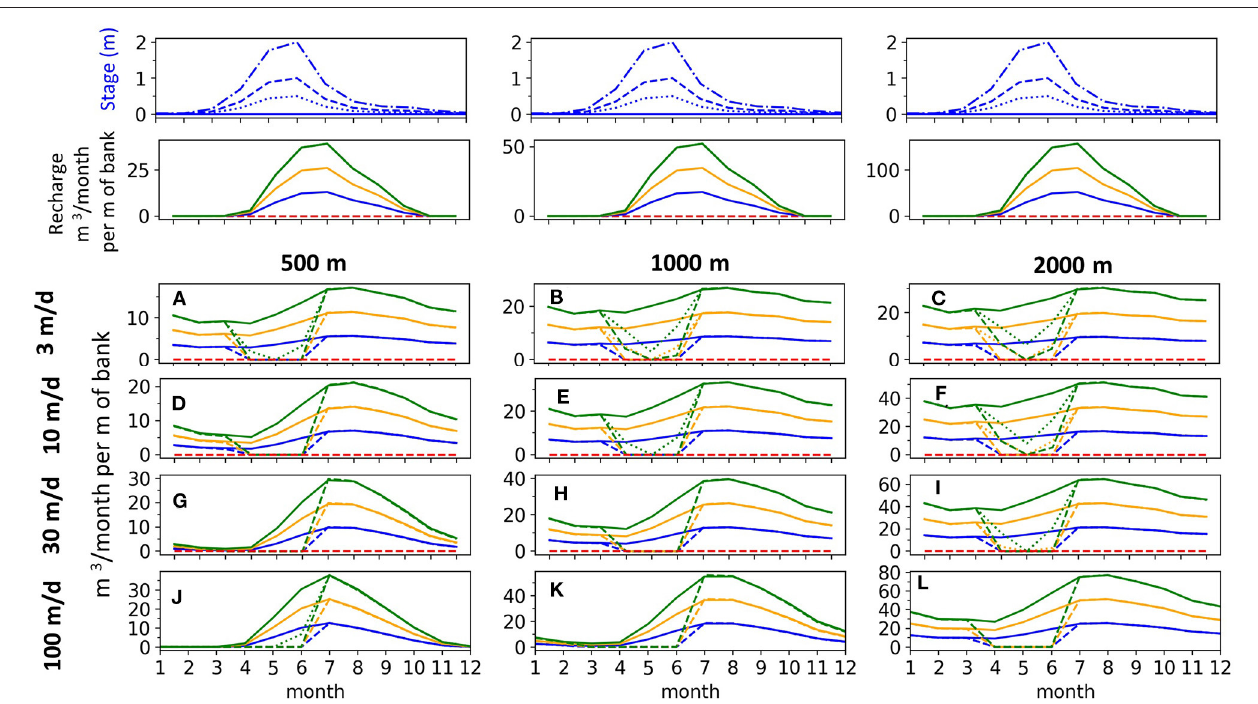
FIGURE 8 | Return flows from three different recharge magnitudes (colors) and four different stream stages (denoted by line style corresponding to the four stream hydrographs in the top row). (A,D,G,J) Are for 500m width, (B,E,H,K) are for 1000m width, and (C,F,I,L) are for 2000m